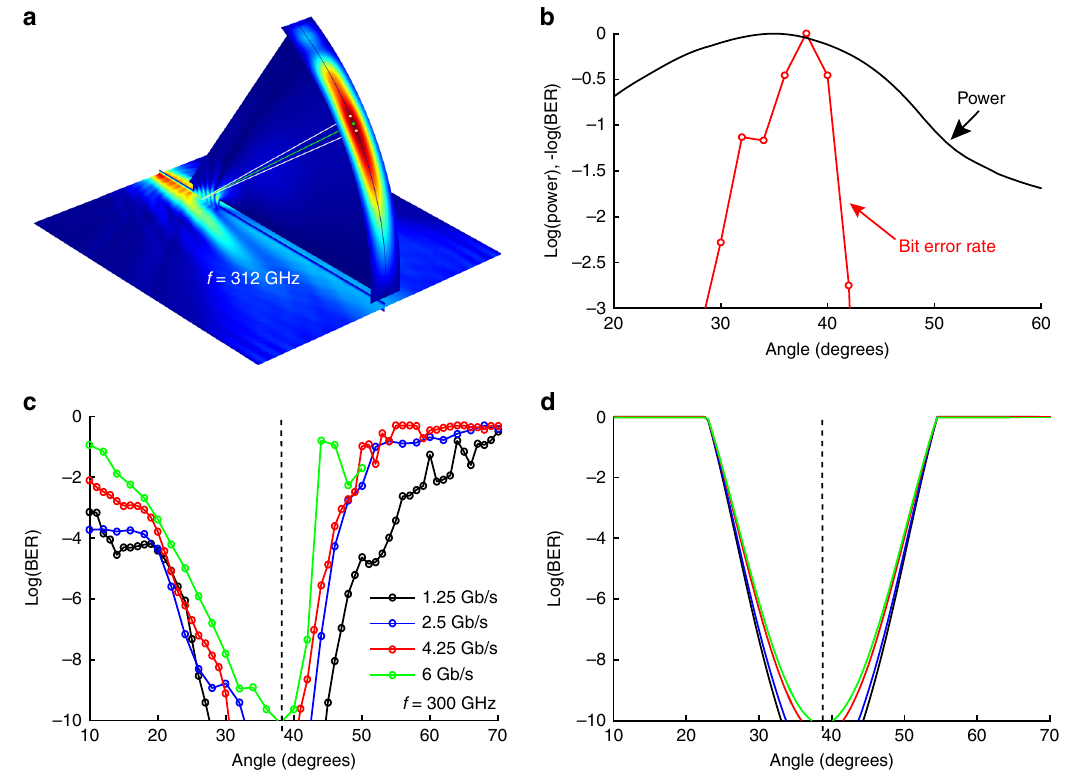
Fig. 1 Demultiplexing of modulated THz channels for different data rates. a A 3D numerical simulation ( fi nite element method), of a single-frequency input wave ( f = 312 GHz) propagating in the waveguide ( b = 0.733 mm) and then radiating into the far fi eld through a slot in the top plate. The horizontal plane shows the intensity in a plane centered between the metal plates (i.e., inside the waveguide). The vertical (out of plane) arc shows the radiated power as a function of angle. The solid green line indicates the angle predicted by Eq. (3) for the parameters used in this simulation. The two solid white lines on either side of the green line show the predicted angles for frequencies of 302 GHz and 322 GHz, corresponding to the ± 1st-order sidebands for a modulation data rate of 10 Gb/s. The angular spread of these sidebands is smaller than the angular width of the carrier wave diffracting through the slot. b Measured angular distributions for the power ( black curve ) and bit error rate ( BER , red symbols ), for an input frequency of 300 GHz and a modulation rate of 6 Gb/s. Both are normalized to unity and plotted on a log scale (BER plotted as the negative log), to facilitate comparison of the angular widths. c Measured real-time BER performance of the THz link coupled out from the slot, as a function of the angular position of the detector, for a 300 GHz carrier wave. Here, the plate separation b is 0.8 mm and slot width is 0.7 mm. Results for several different data rates all show the same optimum angle of 38.7° independent of the data rates (indicated by the vertical dashed line ), though the angular width varies slightly with data rate. d A model calculation of the effect of a non-uniform angular detection sensitivity on the BER, which qualitatively reproduces the observed results. These curves assume a speci fi c (parabolic) form for the angular detection fi lter, but otherwise contain no free parameters (see Supplementary Note 1 for details). In this plot, the colors correspond to the same data rates as in ( c